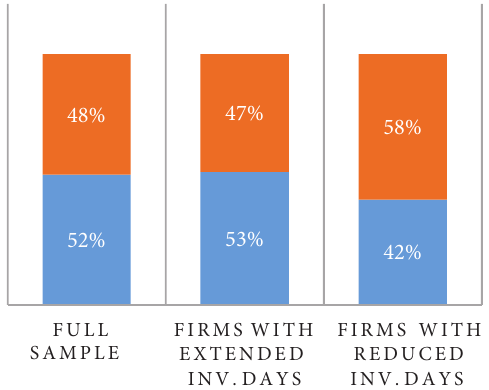
Figure 4. Short-term borrowings and Profitability under the influence of inventory